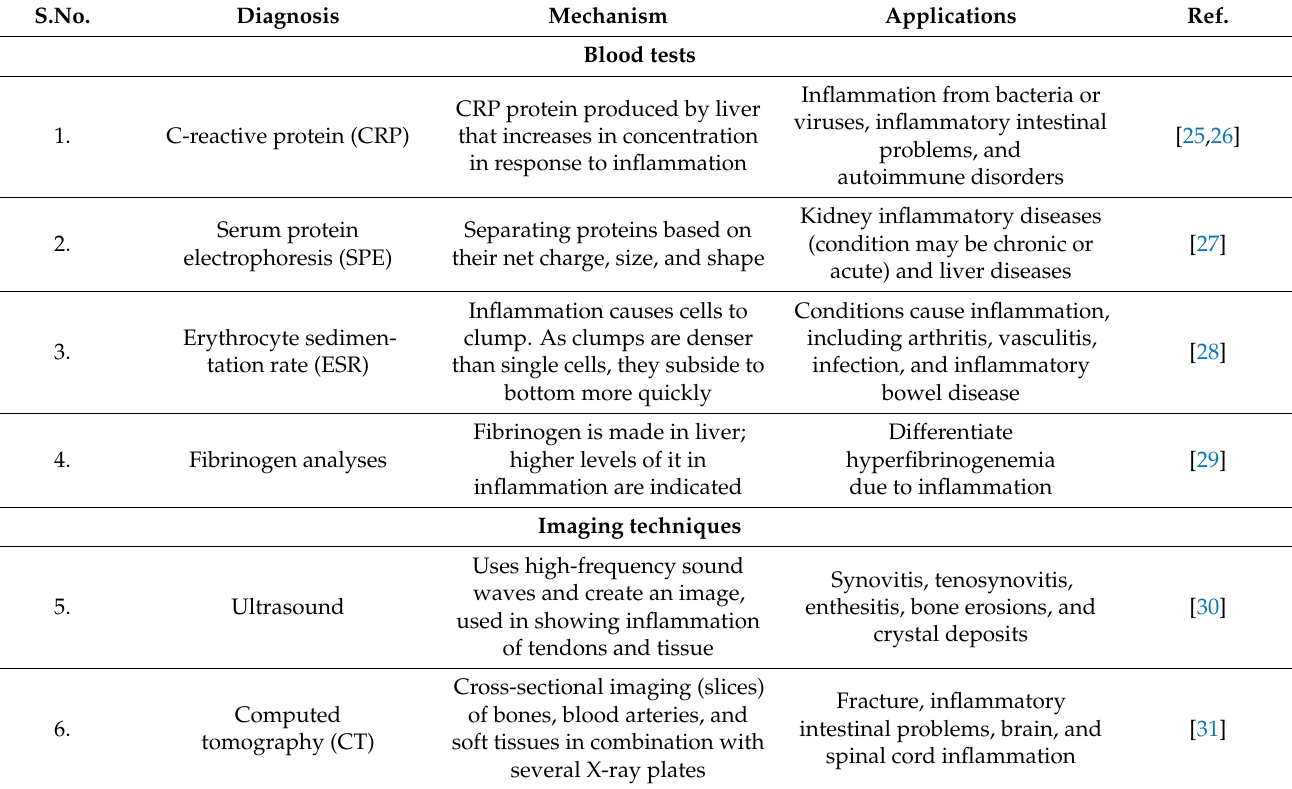
Table 1. Conventional diagnosis of